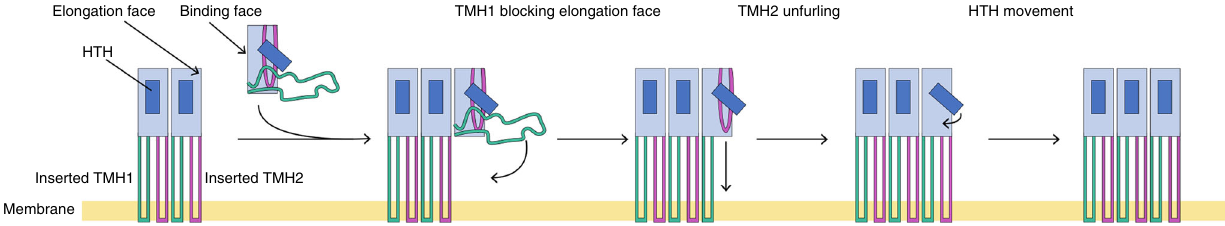
Fig. 4 Schematic diagram of the unidirectional C9 assembly. We hypothesise that during the assembly, binding to the elongation face of a C9 subunit leads to the release of TMH1 which inserts to form a canonical β -hairpin. Following this, the release of TMH2 and a conformational change in the HTH